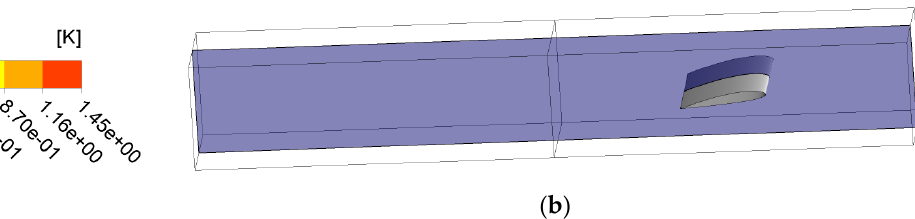
Figure 20. ( a ) Scale of temperature differences on suction side of hydrofoil in Figures 21–28; ( b ) hydrofoil symmetry plane in which vector lines are drawn in Figures 21–28.